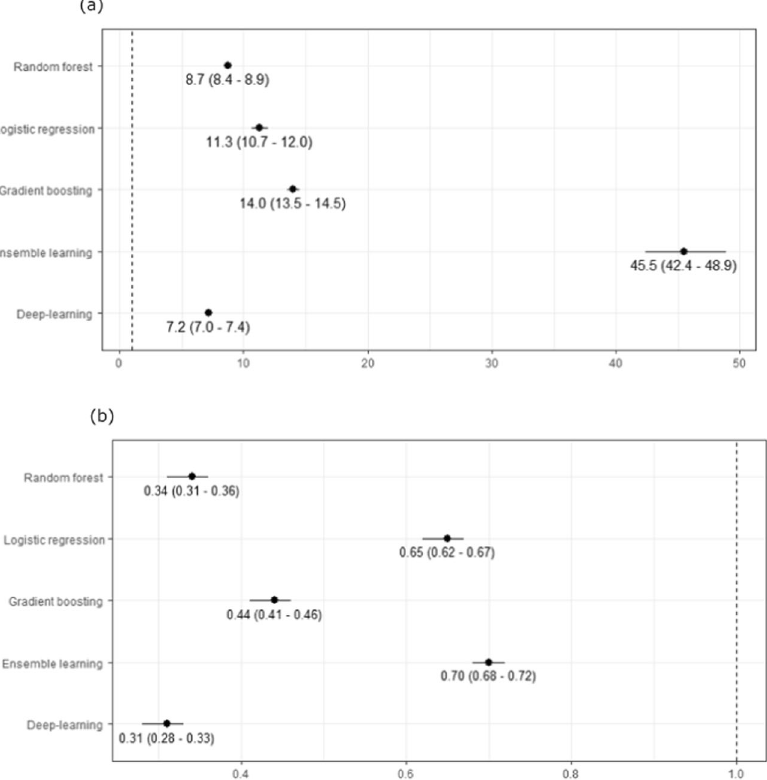
Fig. 5 Positive and negative likelihood ratios for machine-learning models for detecting familial hypercholesterolaemia. Based on validation cohort of 1,006,943 patients: a positive likelihood ratios (95% con fi dence interval) and b negative likelihood ratios (95% con fi dence